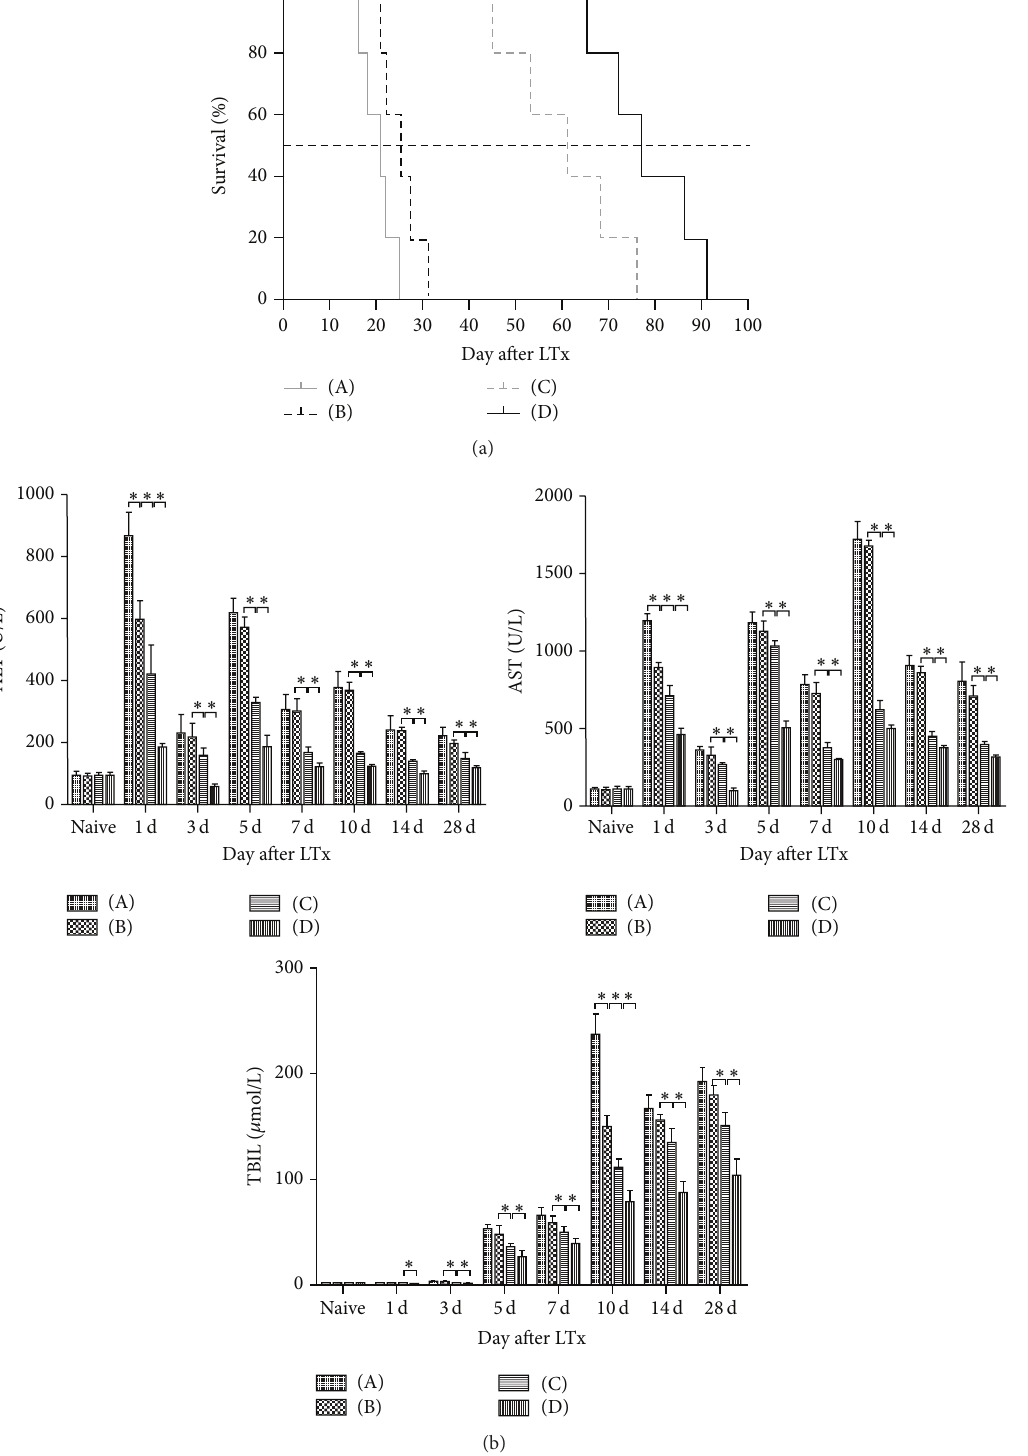
Figure 2: Kaplan-Meier survival curve of recipients. (A) Normal saline group; (B) HO-1 group; (C) BMMSCs group; (D) HO-1/MSCs group. (a) Median recipient survival times were 77, 61, 25, and 21 days in the HO-1/MSCs group, BMMSCs group, HO-1, and normal saline groups, respectively ( 𝑛 = 5 per group). Survival rates were significantly improved in the HO-1/MSCs treatment group compared with the three control groups ( 𝑃 < 0.05 ). (b) Levels of ALT, AST, and TBIL were significantly lower in the HO-1/MSCs group compared with control groups at all time points ( ∗ 𝑃 < 0.05